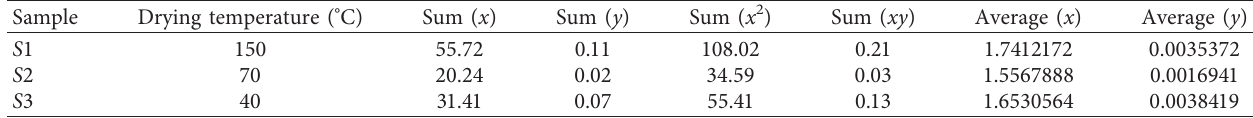
Table 2: The numerical parameters of equations (3) and (4).